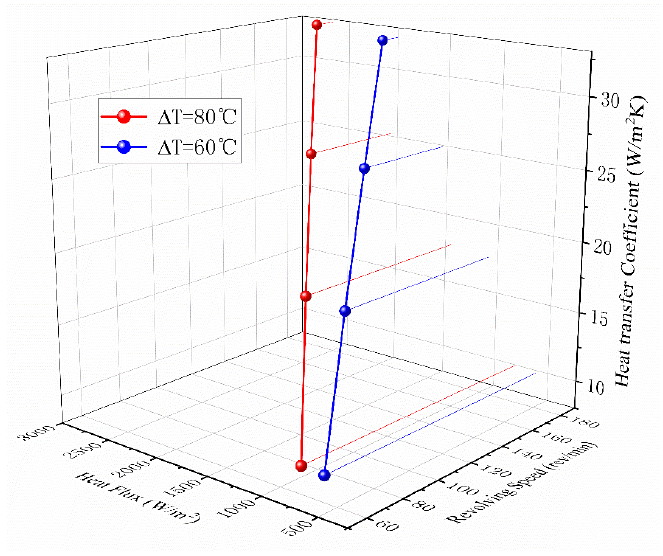
Figure 6. T he heat transfer coefficient of air-cool stage. Figure 6. The heat transfer coefficient of air-cool